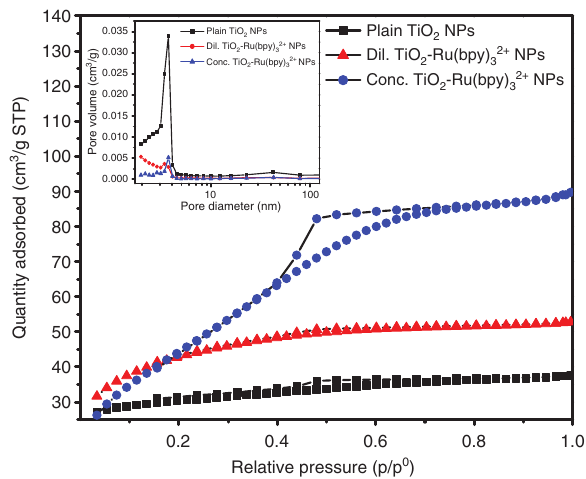
adsorption-desorption isotherms of the plain TiO Figure 3: N 2 diluted and concentrated TiO